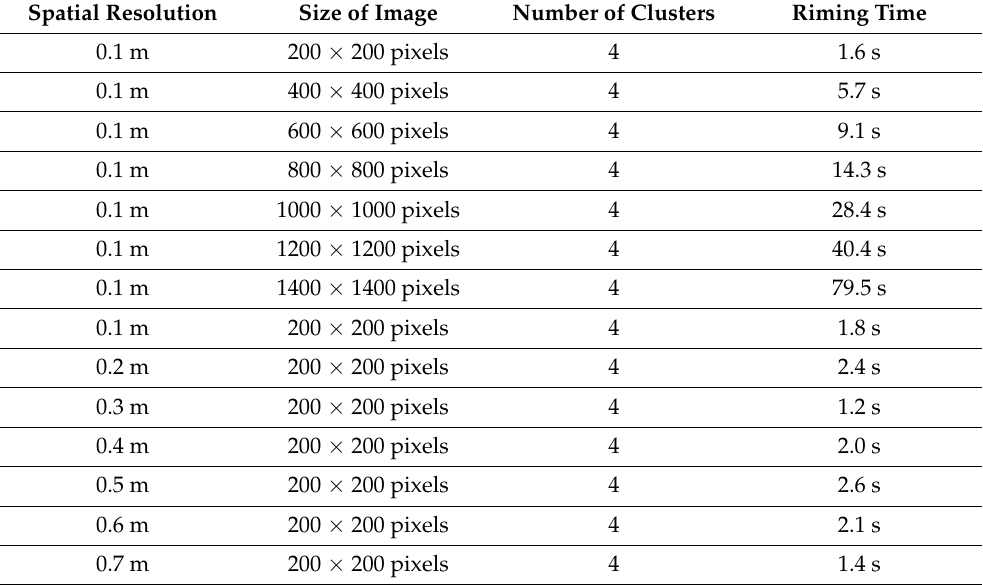
Table 9. The running time of SSIFCM for remote sensing images of different sizes and resolutions. Spatial Resolution Size of Image